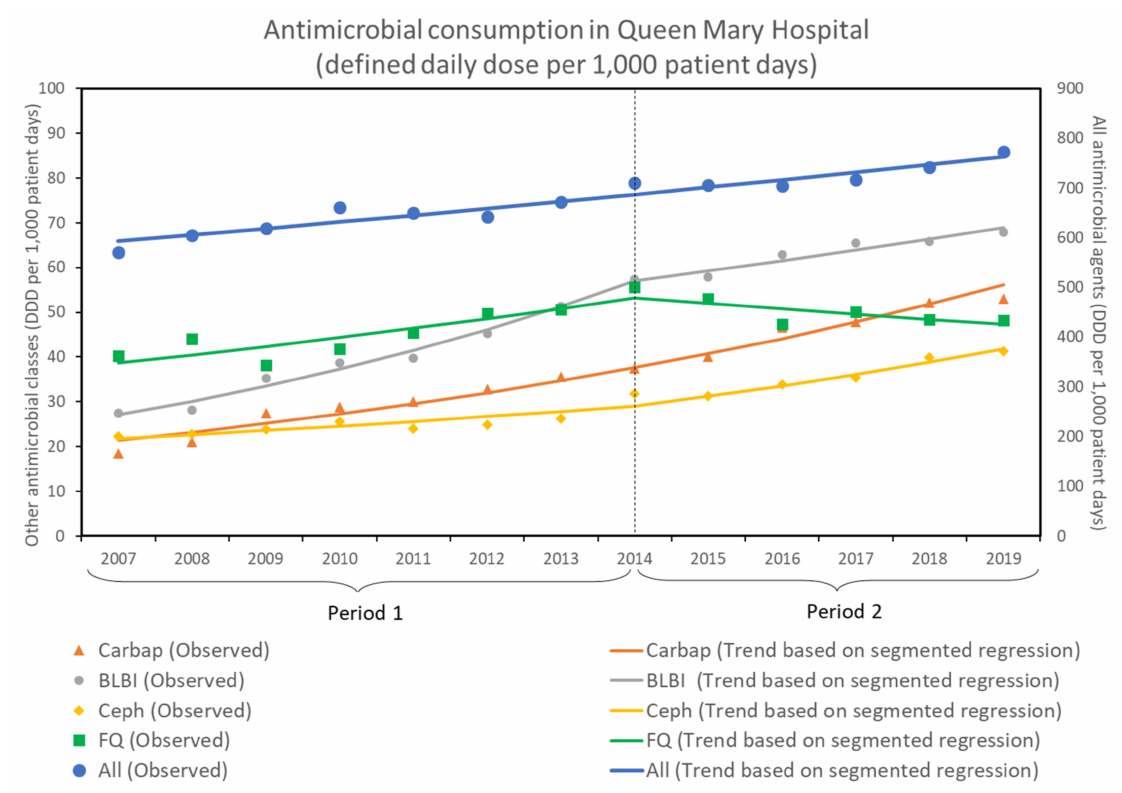
Figure 4. Antimicrobial consumption in Queen Mary Hospital before and after the enhance- ment of infection control measures. All, all antimicrobial agents; BLBI, extended spectrum betalactam-betalactamase inhibitor combination; Carbap, carbapenems; Ceph, cephalosporins; FQ;